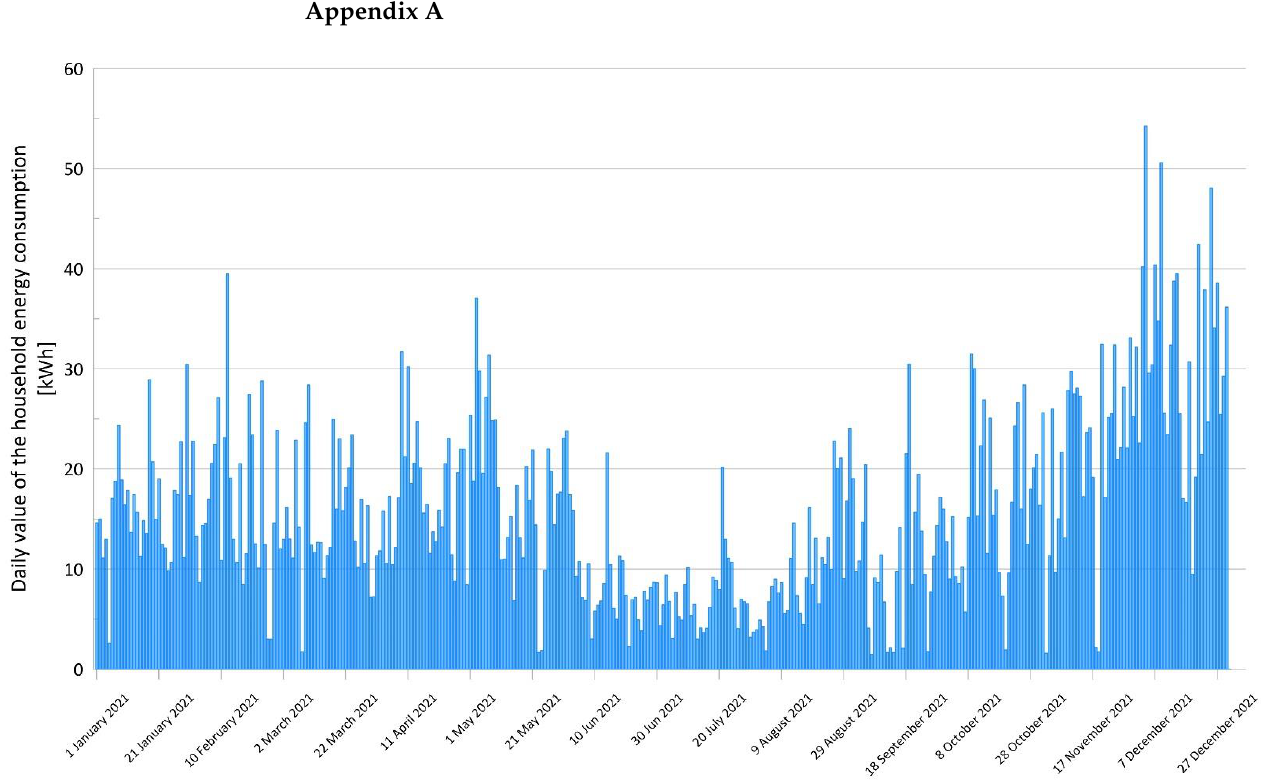
Figure A1. Daily values of household energy consumption during the year 2021.